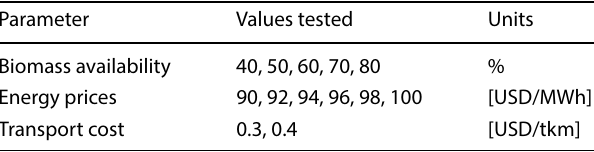
Table 1 Parameters that were altered across the different scenarios considered. The algorithm was run once for each combination of these